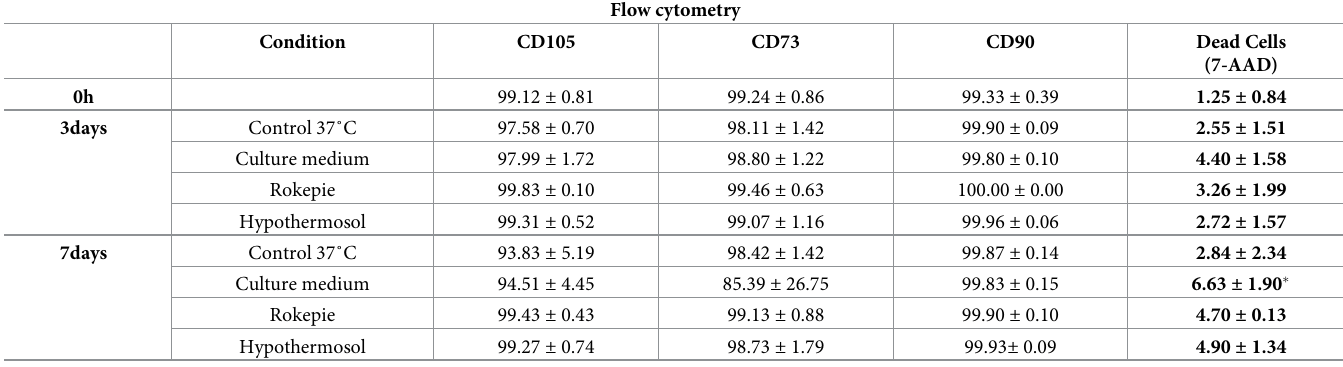
Table 1. Flow cytometry analysis of mesenchymal and viability markers. Flow cytometry analysis of confluent hASCs cultured at 4˚C, in the presence and absence (cul- ture medium) of hypothermic storage solutions for 3 and 7 days. A control culture at 37˚C was also performed. Values for 0 hours correspond to cells before 4˚C incuba- tion. Mesenchymal markers CD105, CD90, CD73 as well as the viability marker 7-AAD were